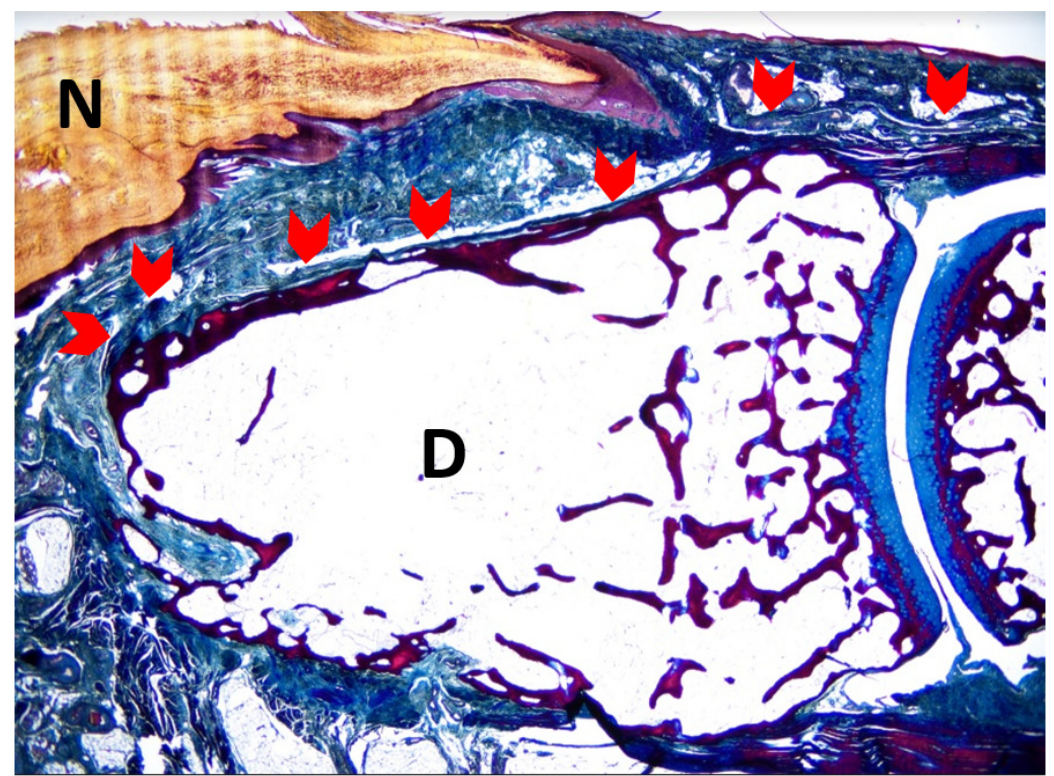
Figure 2. Sagittal section of the second toe at the midpoint of the nail matrix. The superficial fibers of the Extensor Digitorum Longus (EDL) tendon bundles extend to the dorsal aspect of the distal phalanx of the second toe (red arrowheads). N—nail plate; D—distal phalanx. (5× magnification). Tetrachrome VOF-III GS stain (light green SF/or fast green FCF, methyl blue, Orange G, and acid fuchsin). Scale bar = 5× magnification